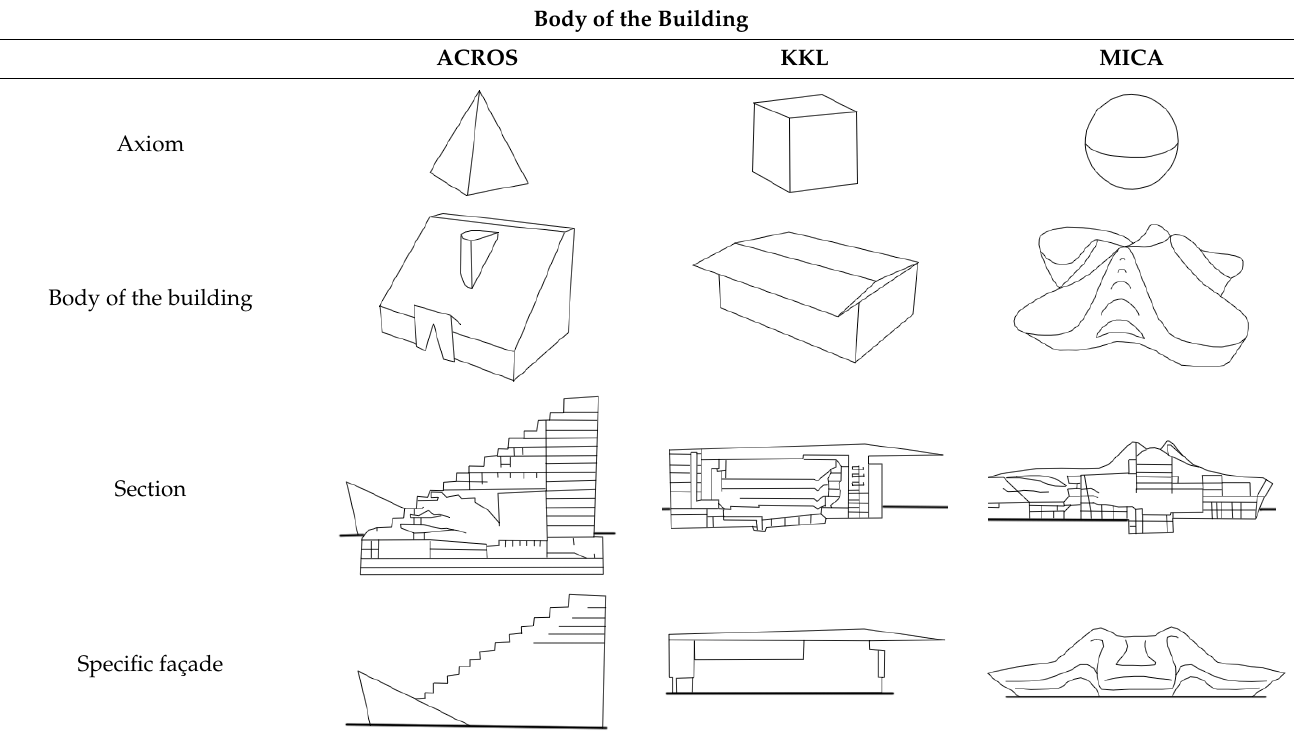
Graphic processing by E. Latusek.